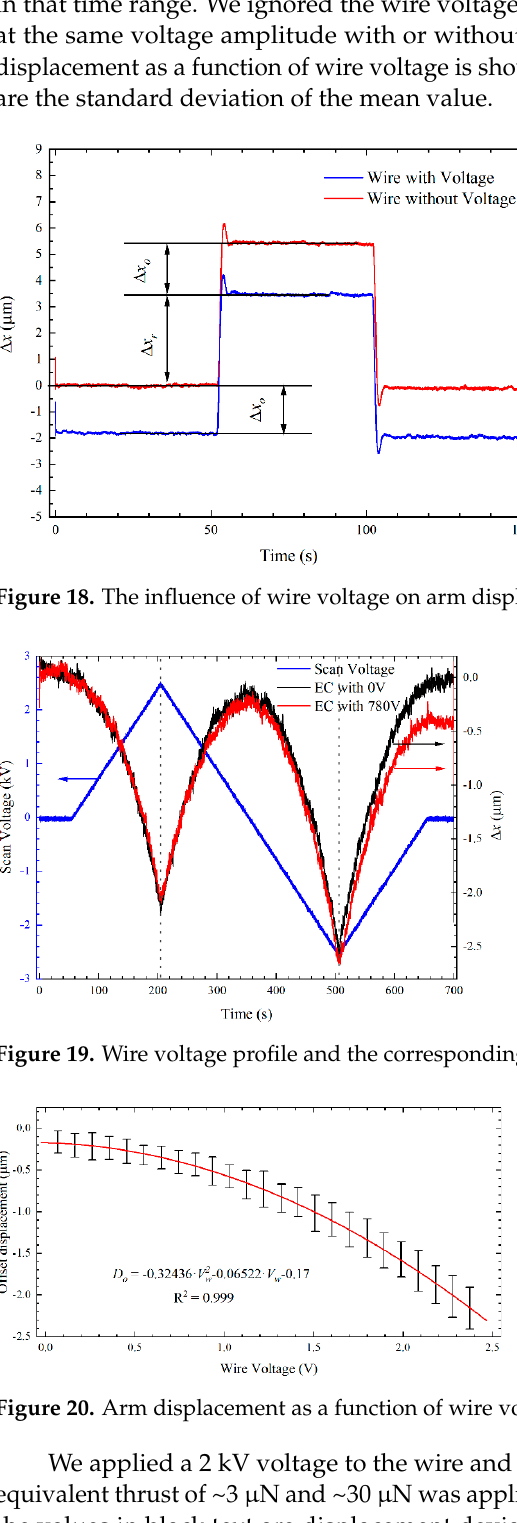
Figure 19. Wire voltage profile and the corresponding arm displacement.